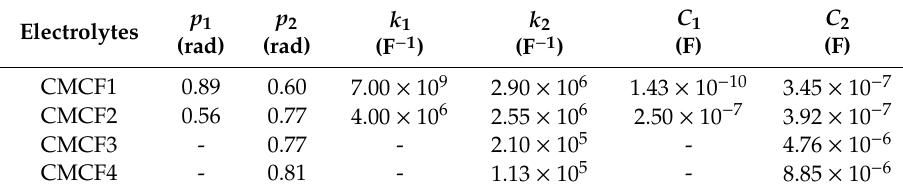
Table 2. The parameters of the circuit elements of the blend electrolytes.